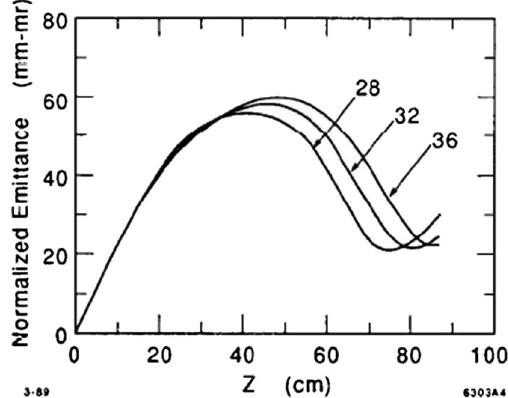
FIG. 9. SLAC simulations (from [19]) verifying the ability to compensate the emittance growth from axially dependent space- charge forces. The numbers in the plot indicate the location of the lens in